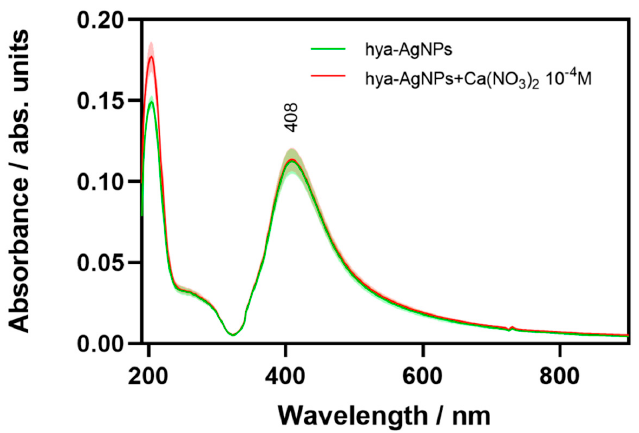
Figure 2. Mean UV-Vis spectra of as synthesized hya-AgNPs and after the addition of Ca(NO 3 ) 2 10 − 4 M to the hya-AgNPs. The standard deviation is represented by the shaded area.